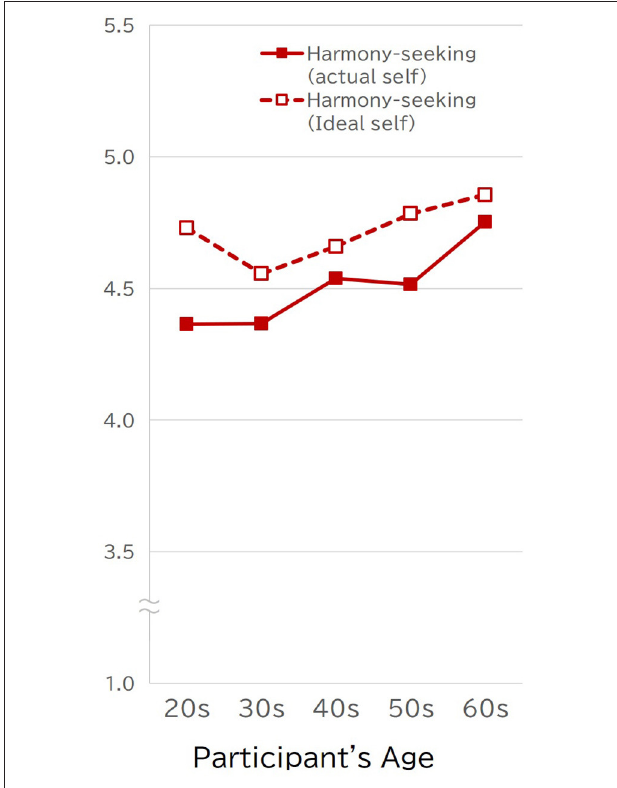
FIGURE 3 | Actual and ideal self scores on the harmony-seeking scale across respondents’ age (Study